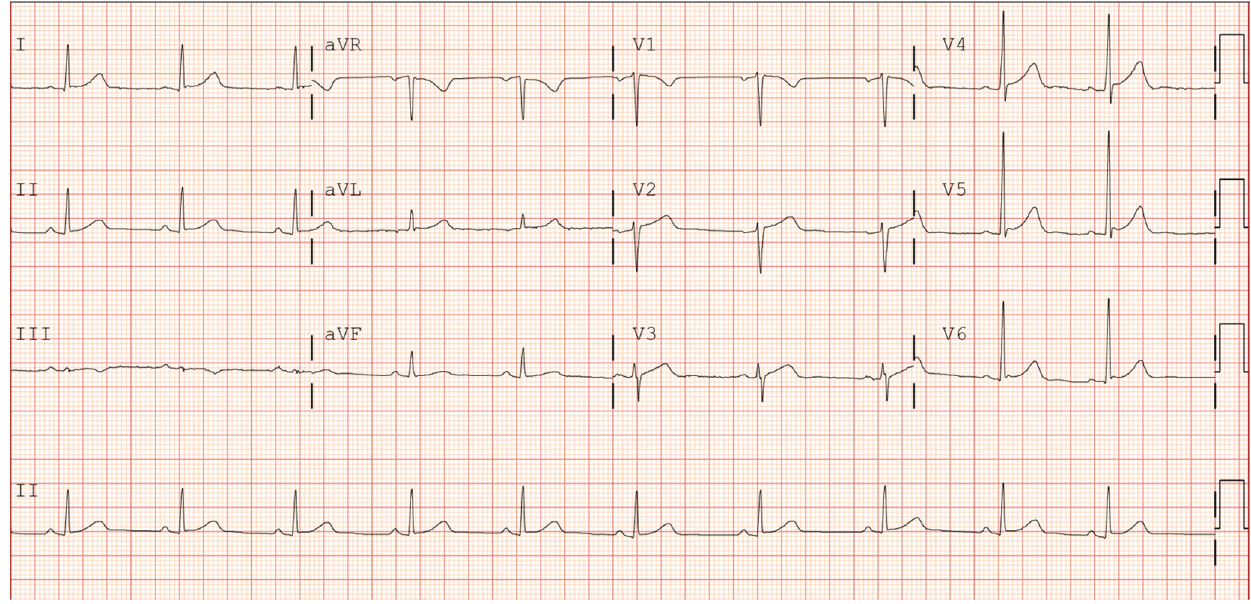
Figure 2: ECG two days after admission demonstrating absence of characteristic Brugada